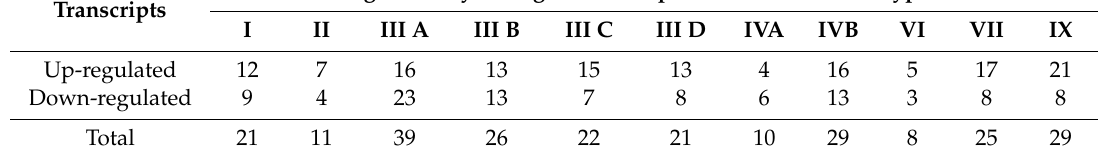
Table 3. Number of up- and down-regulated transcripts of genes related to behavior (term GO:0007610 in the QuickGO database) in di ff erent types of MPS relative to control cells